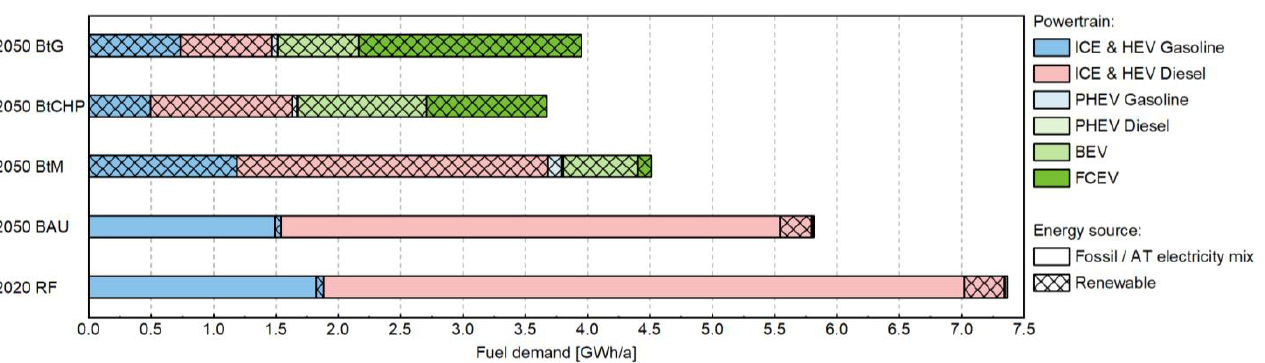
Figure 7. Comparison of final heat ( a ) and electricity ( b ) demands of the reference case (2020) with assumed scenarios (2050).